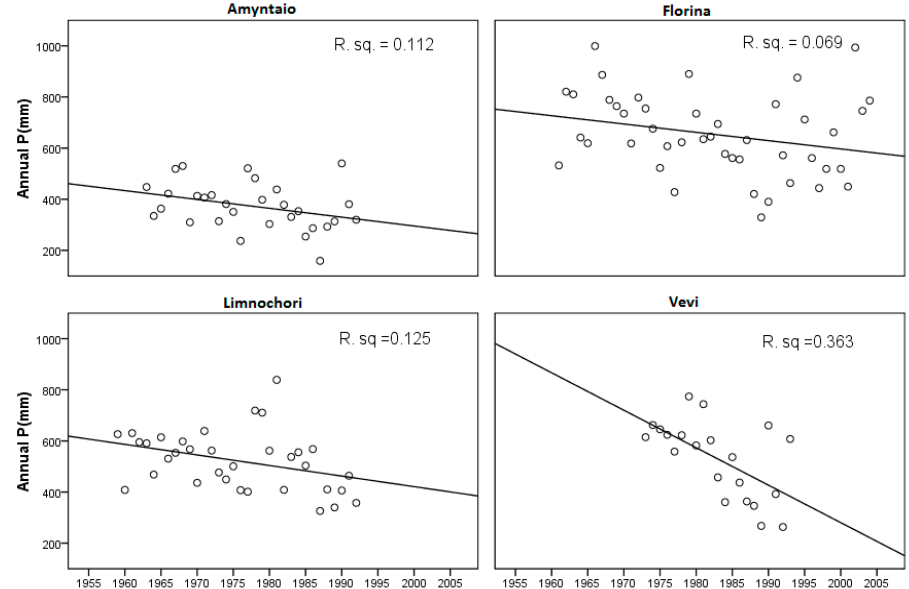
Figure 2. Precipitation trends in the studied area (data available from four separate meteorological stations from 1959 to 2004).